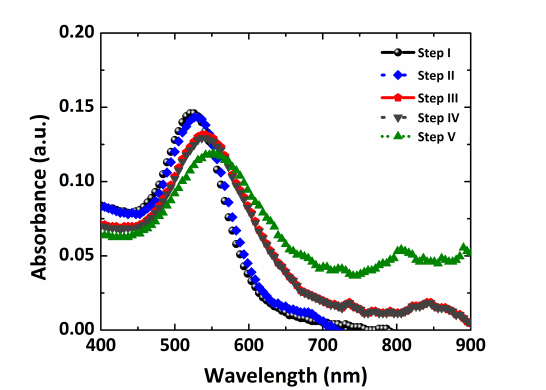
Figure 8. Plasmon resonance peak shift ( ∆ λ ) on increasing the dielectric shell around the particle ( a ) and the variations in LSPR peak positon due to cysteamine interaction with Au NPs as a function of time ( b ).